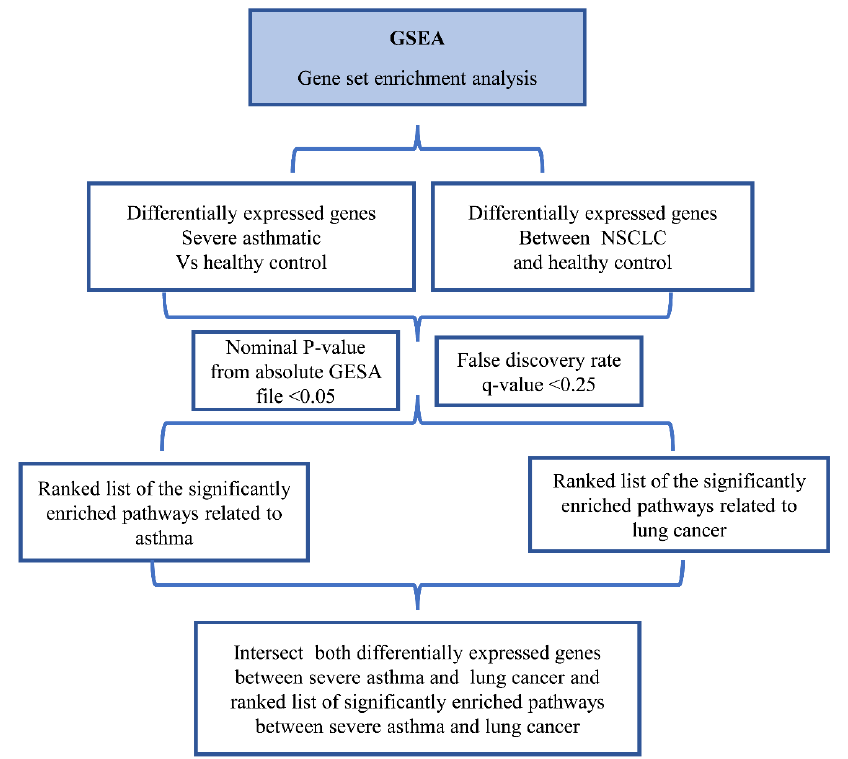
Figure 3. Flowchart of the bioinformatics approach used to identify gene sets related to severe asthma and lung cancer.